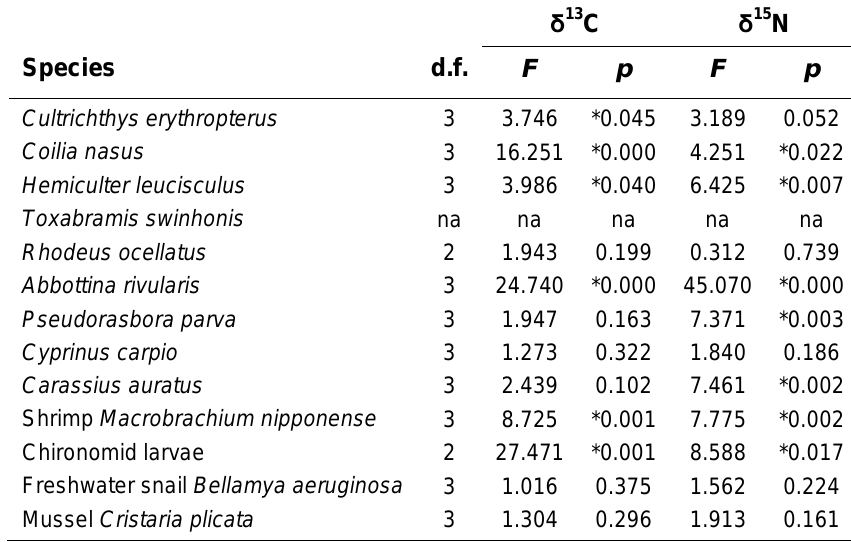
One-Way ANOVA Results Showing Seasonal Variations in Stable Isotope Ratios ( δ 13 C and δ 15 N) of 11 Target Consumers and Two Baseline Indicators with Species and Season as the Main Factors δ 13 C